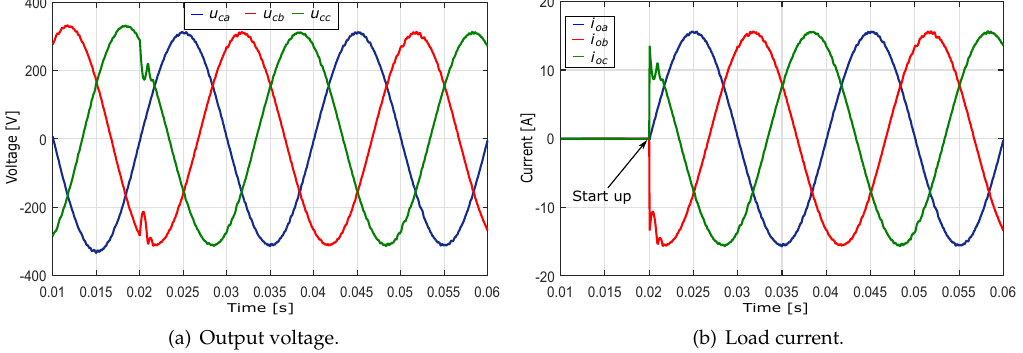
Figure 12. Output voltage and current with the resistive load step at t = 0.02 s.